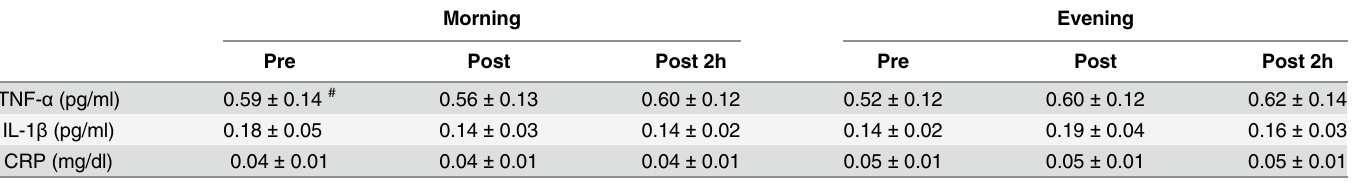
Value are mean ± SE, TNF- α , Tumor necrosis factor-alpha; IL-1 β , Interleukin-1 β ; CRP, C-reactive protein. # P < 0.05 compared with level (Pre) in the Evening